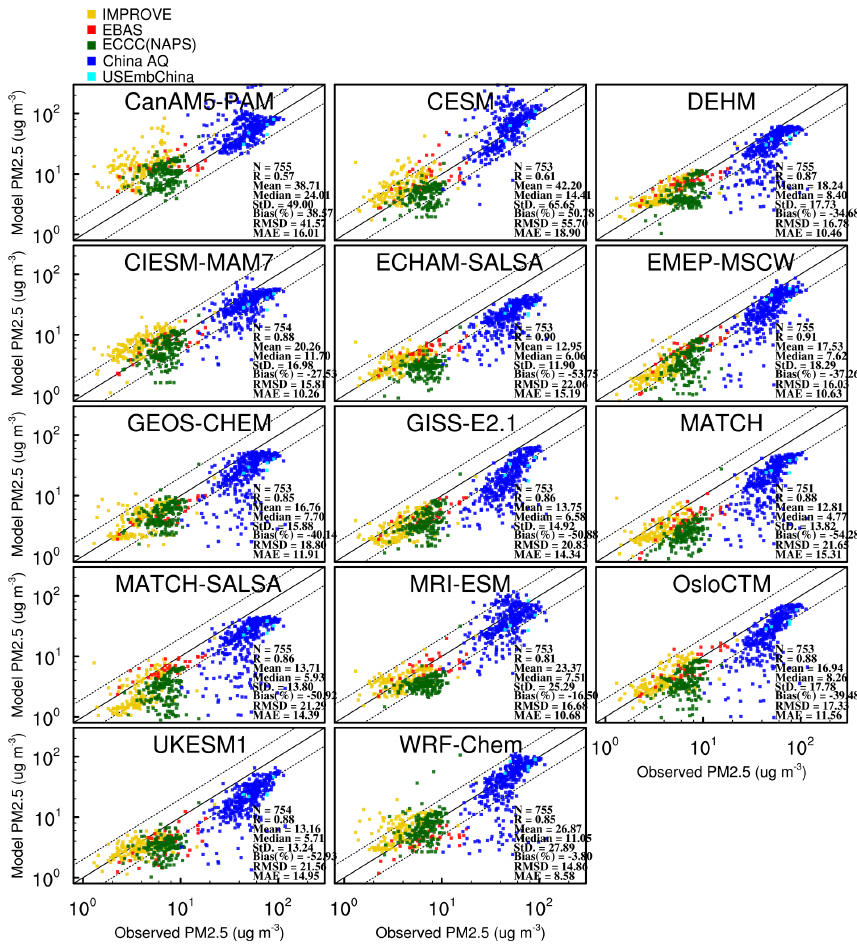
Figure 24. Annual mean PM 2 . 5 comparisons between station observations and model simulations for the year